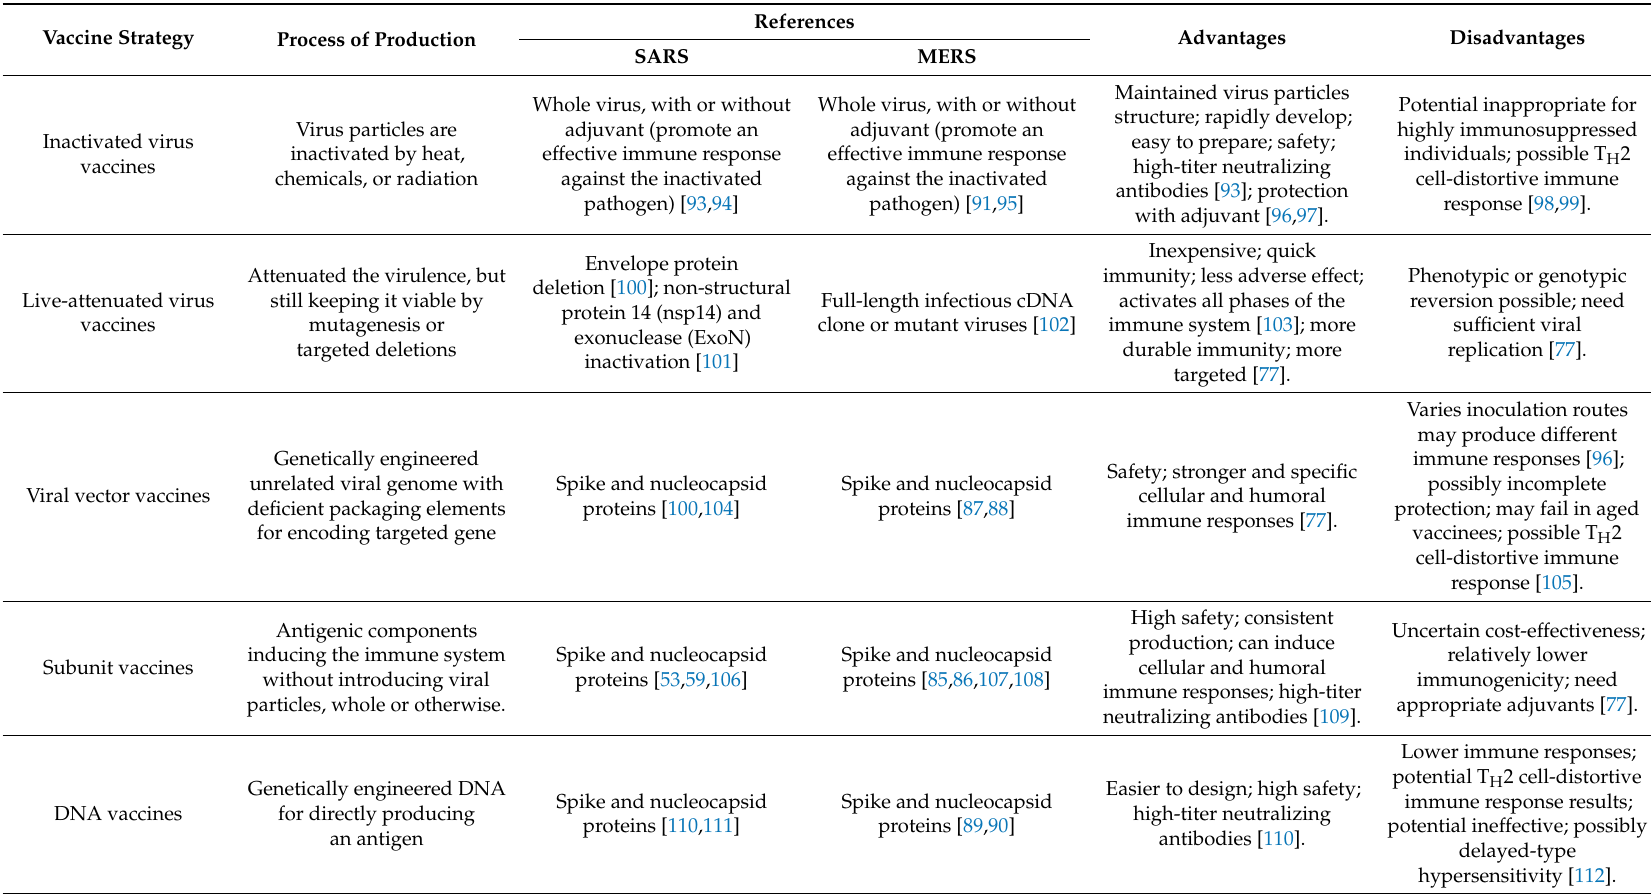
Table 3. Vaccine strategies of SARS-CoV and